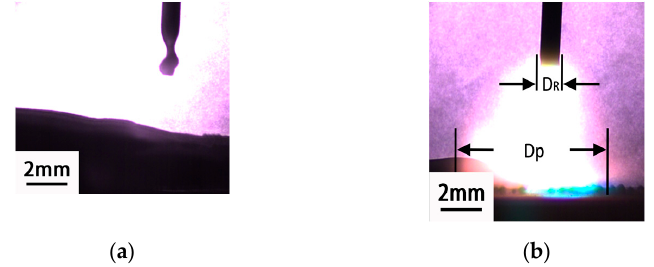
Figure 5. ( a ) Complete filtering out of the arc; ( b ) typical nature of arc profile.